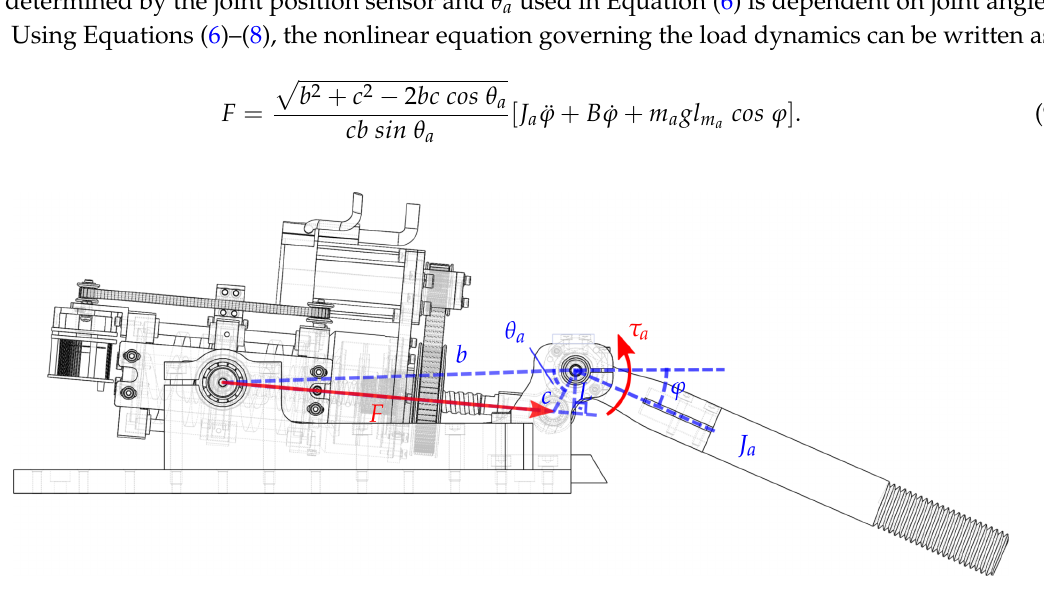
Figure 8. Kinematic structure of the joint link mechanism.